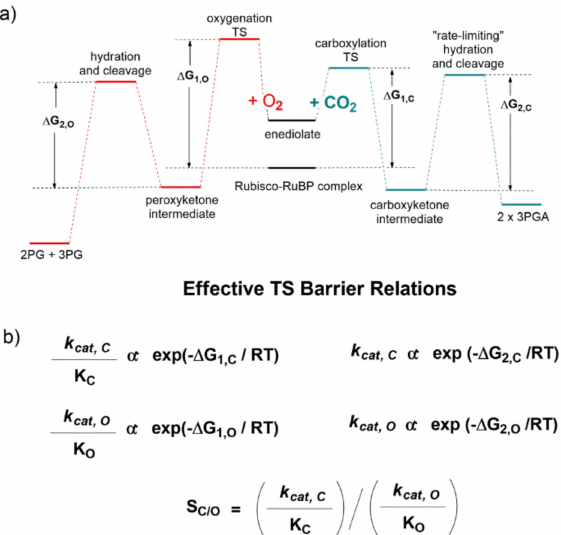
Figure 17. ( a ) The reaction coordinate diagram describes carboxylation (traits in green) and oxy- genation (traits in red) reactions proceeding through two “effective” barriers. After Rubisco binding to the active site, the substrate undergoes enolization. The first effective barrier refers to the gas addition (CO 2 or O 2 ) to the enediolate, while, considering the carboxylation reaction, the second effective barrier (rate-limiting) encompasses C2-carboxylic acid hydration and C2-C3-gemdiolate bond cleavage reactions; ( b ) Given standard assumptions, the authors have concluded that catalytic efficiencies (k cat /K M ) for the carboxylation and oxygenation reactions are related to the height of the first effective barrier while k cat is related to the second effective barrier. (Figure 17 from ref. [51], adapted and used by permission of American Chemical Society (copyright ©